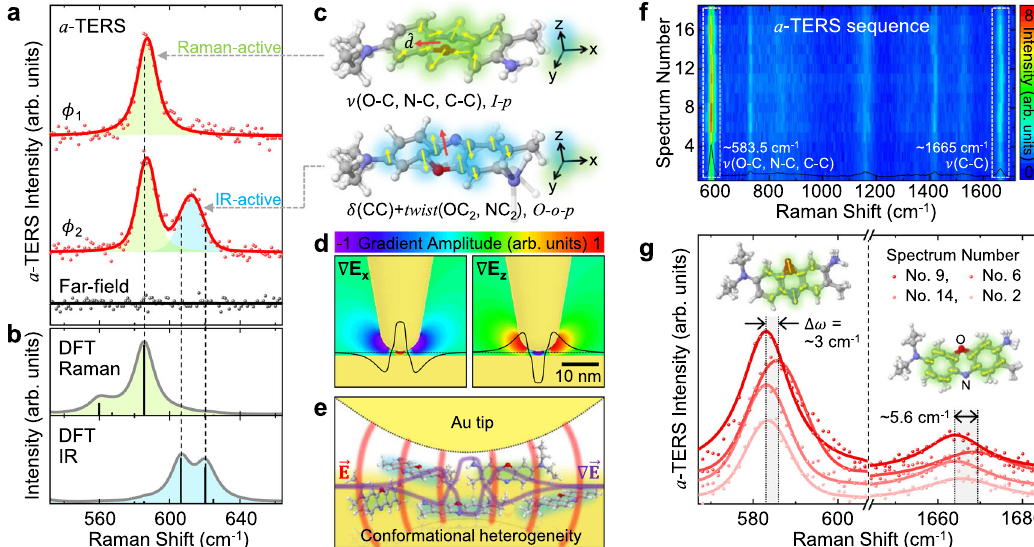
Fig. 4 Symmetry-selective tip-enhanced Raman spectroscopy of BCB molecules. a Measured far- fi eld (black) and wavefront-shaped TERS ( a -TERS, red circle) spectra for BCB molecules with Voigt pro fi le fi t (red line). Distinct a -TERS spectra ( ϕ 1 and ϕ 2 ) are observed with near- fi eld polarization-control. b Calculated vibrational spectra of a BCB molecule with Raman-active (green) and IR-active (blue) normal modes. c Illustrations for the vibrational modes of ~583.5 cm − 1 (top) and ~620 cm − 1 (bottom) peaks (vibrational mode of ~606 cm − 1 peak is similar to ~620 cm − 1 peak). Blue, red, gray, and white atoms indicate nitrogen, oxygen, carbon, and hydrogen, respectively. Abbreviations used: stretching ( ν ), bending ( δ ), in-plane ( i-p ), out-of-plane ( o-o-p ), and dipole derivative unit vector ( ^ d ). d Simulated in-plane ( ∇ E x ) and out-of-plane ( ∇ E z ) optical fi eld gradient distribution in the vicinity of Au tip with gradient amplitude pro fi le at the horizontal plane 1 nm underneath the tip (black line). Hyperbolic tangent function is used for normalized amplitude scale. e Illustration of the conformational heterogeneity of molecules in the tip-substrate gap. f Time-series of a -TERS spectra with dynamic wavefront shaping, exhibiting spectral fl uctuation due to the symmetry-selective TERS response of heterogeneously oriented molecules. g Selected a -TERS spectra from the regions indicated by the white dashed boxes in ( f ). Voigt pro fi le fi ts (solid line) show apparent peak shift of the in-plane stretching modes (~583.5cm − 1 and ~1665 cm − 1